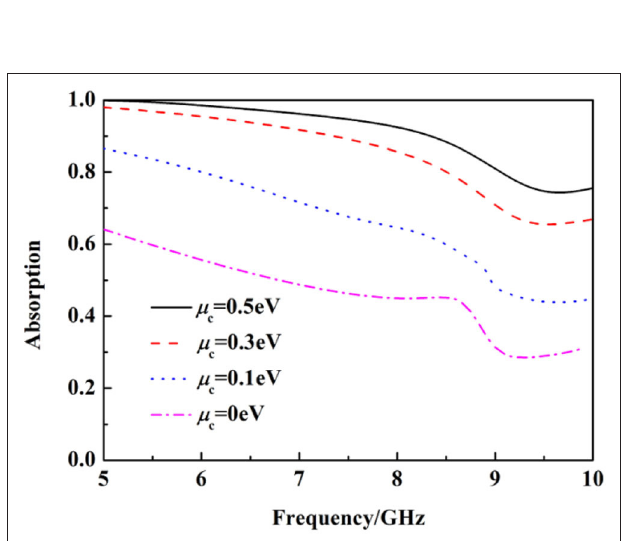
FIGURE 4 | The real part of normalized input impendence of the metamaterial absorber with free space.